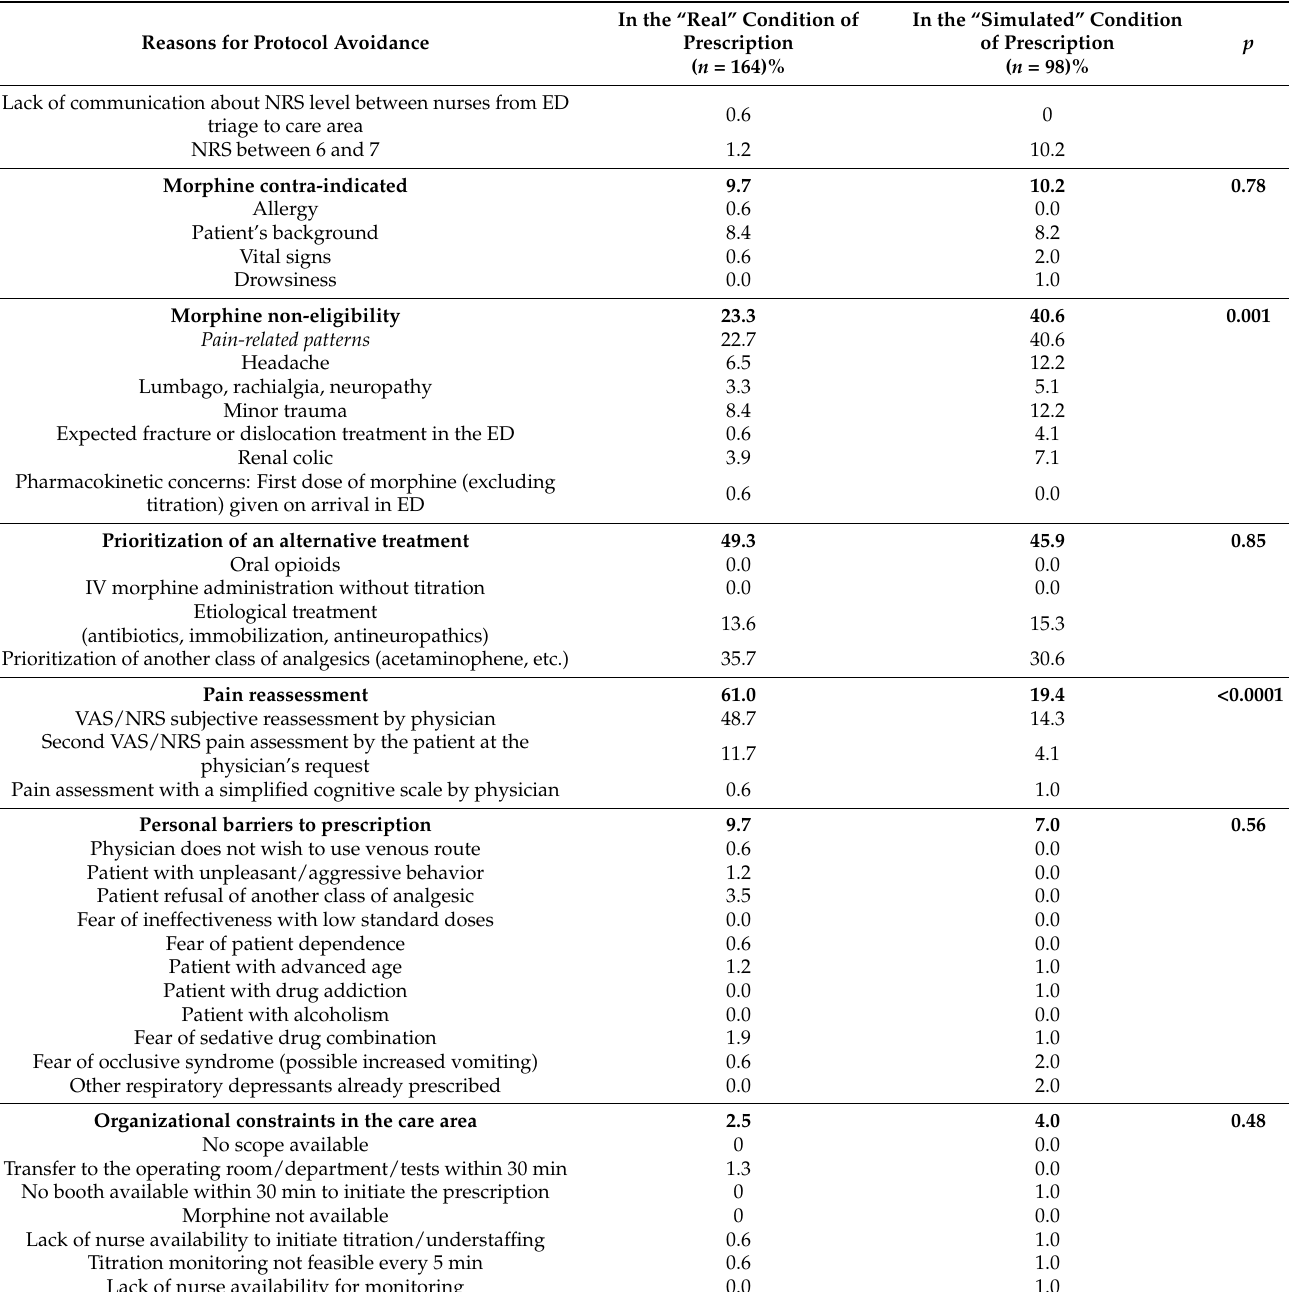
Table 2. Reasons for protocol avoidance leading to morphine saving at bedside in the two parallel assessments of professional practices: in the “real” condition vs. in the “simulated” condition of